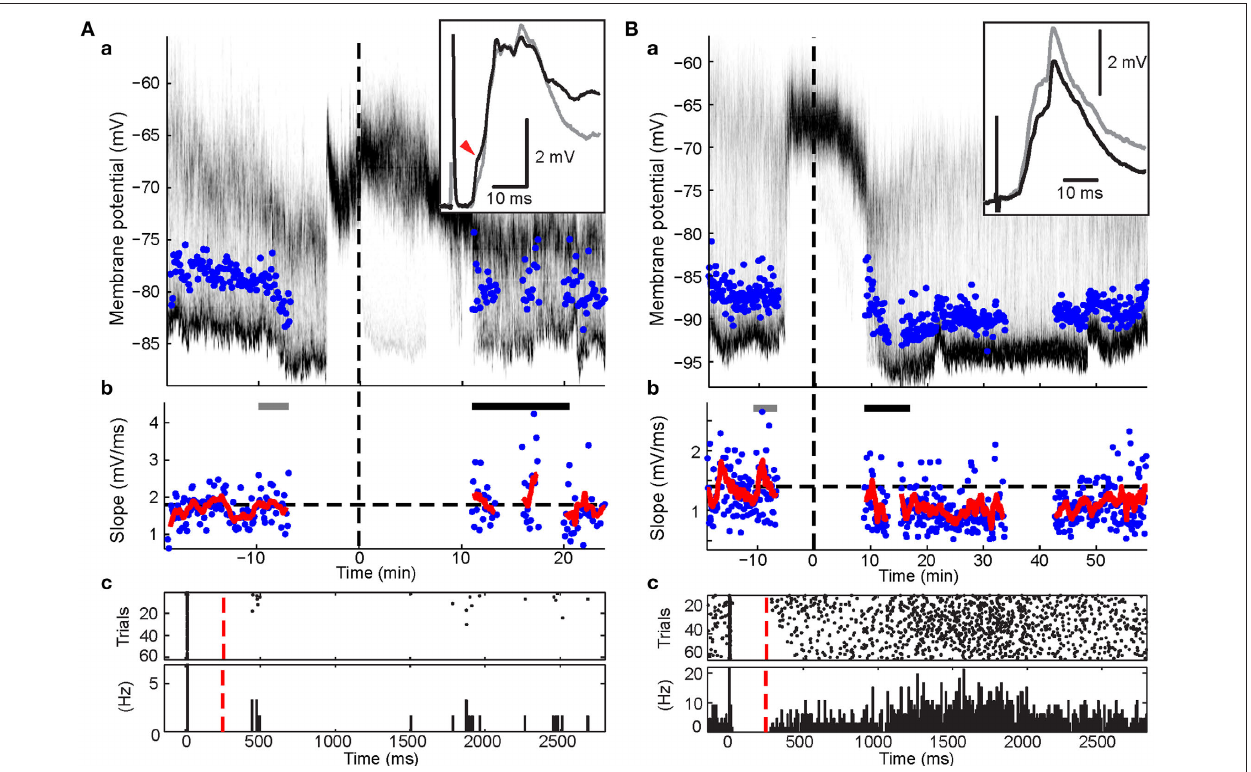
Figure 4 | effects of post-light spike rate on cortico-striatal plasticity in experiments involving pre-post pairing. Format for panels a and b is the same as in Figure 3 . Panels c, raster plot and peri-stimulus time histogram of spikes during the pairing protocol. Cortical stimulus was applied at 0, the intracellular current pulse at approximately 10 ms, and light at 250 ms